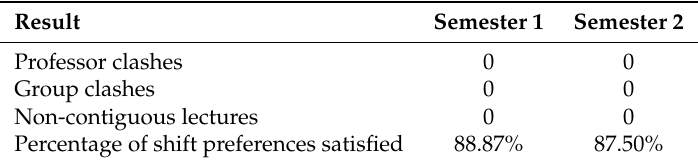
Table 4. Results obtained in the TTP stage for both